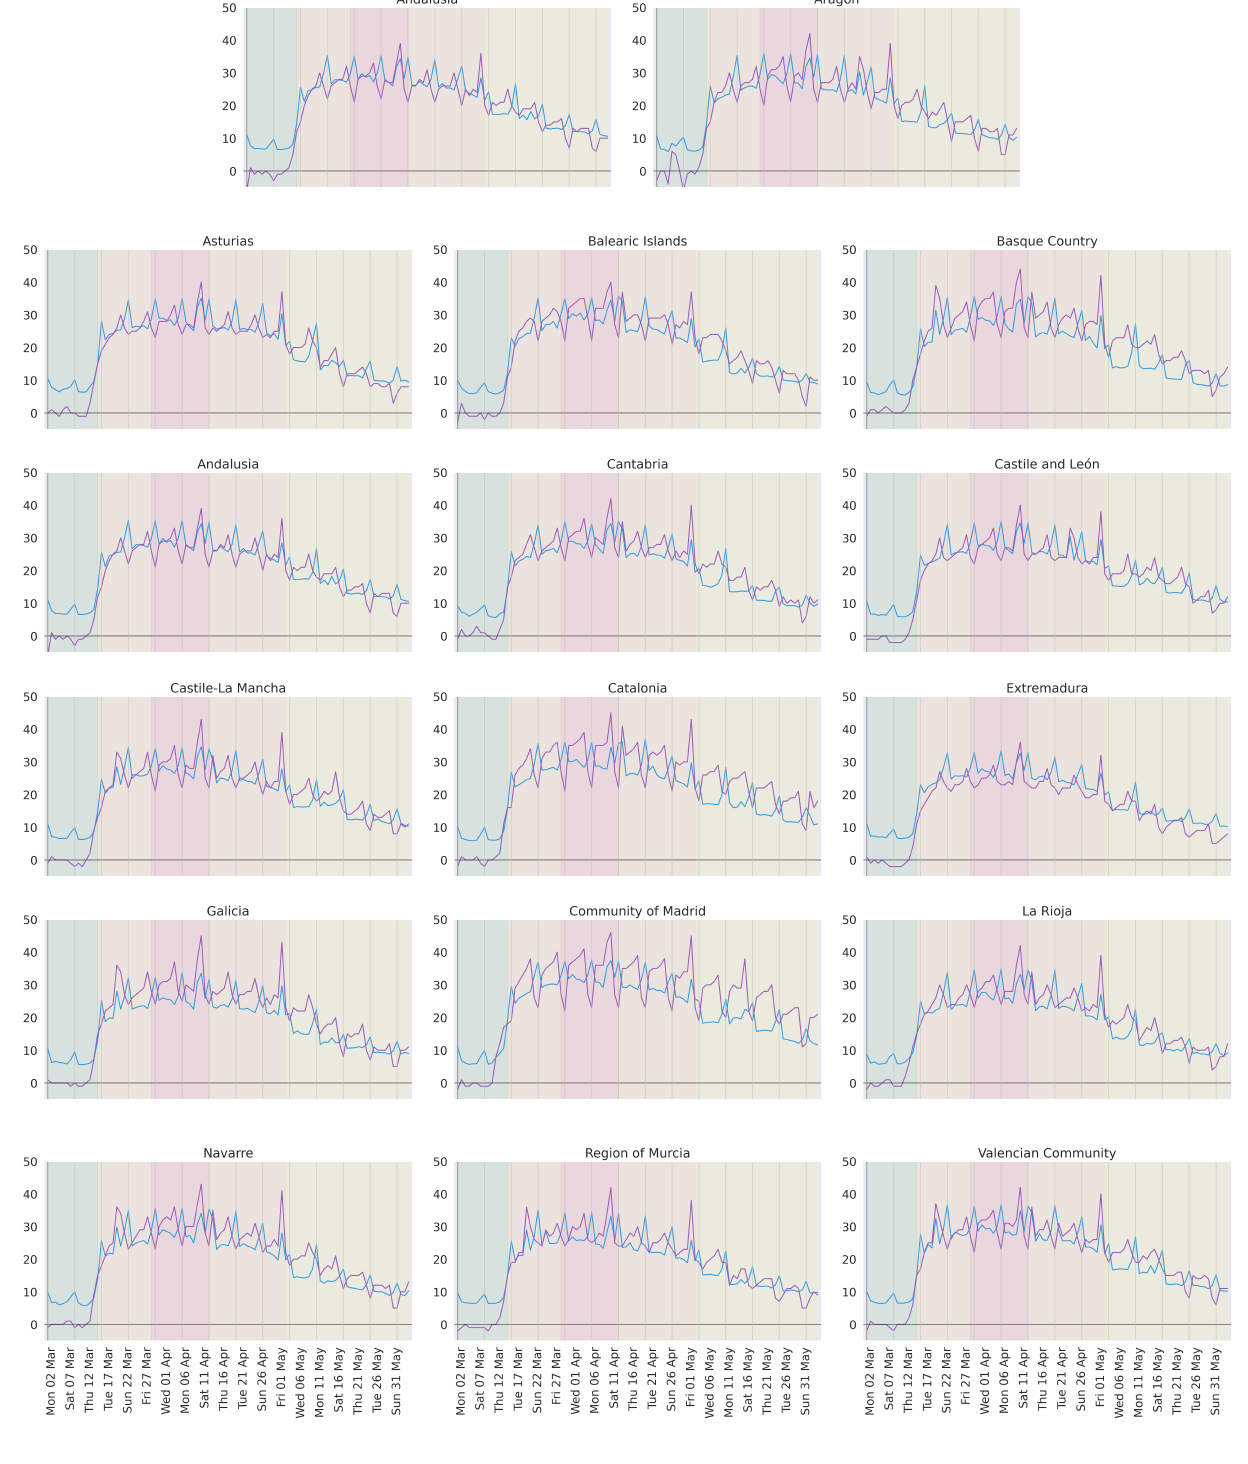
Figure 1. Evolution of mobility according to Facebook (blue) and Google (purple) indices, from March to May. The vertical bands (green, orange, red, orange, green) correspond to pre-confinement, state of alarm declaration and lockdown, hard lockdown, lockdown and de-confinement stages. Grey vertical lines are aligned with every